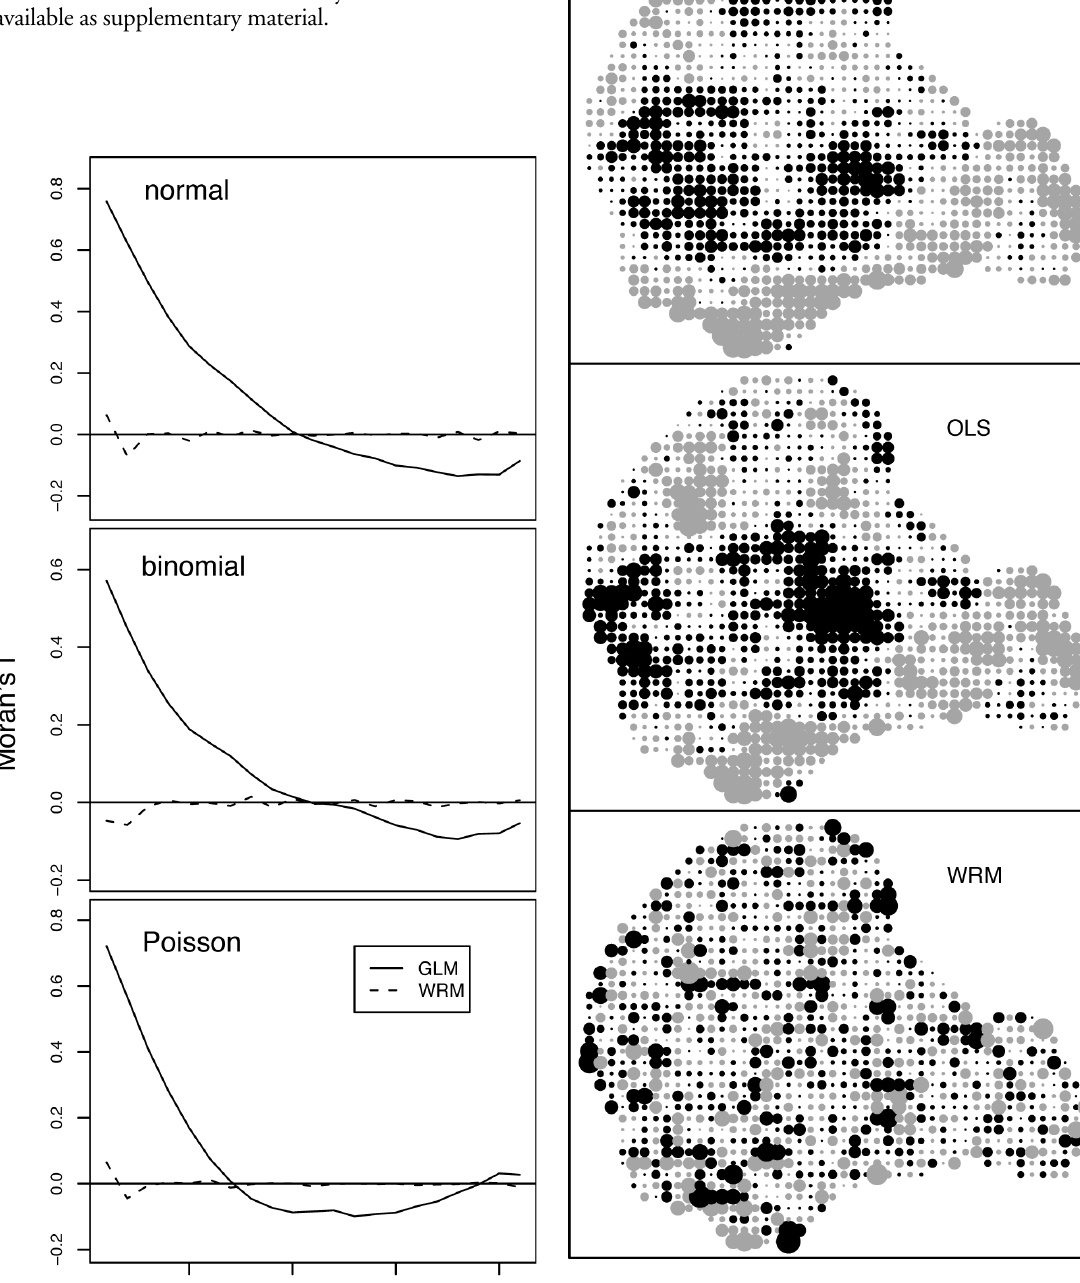
Fig. 3. Raw distributional data and residual maps for the different methods for one realisation of the data with normally distributed responses. On the residual maps, pixel sizes indicate sizes of resid- uals. The two colours black and grey represent the positive and negative signs of residuals, and areas of equal colour indicate au- tocorrelation. For WRM residuals the areas of equal colour are essentially reduced compared to OLS